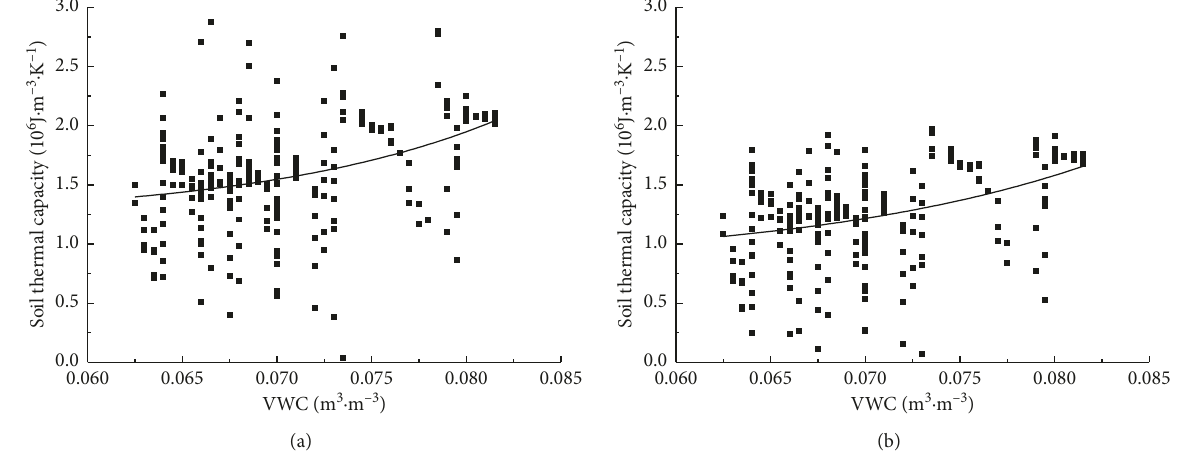
Figure 7: Variations in the soil thermal capacity with the VWC: (a) water-bearing soil and (b) water-free